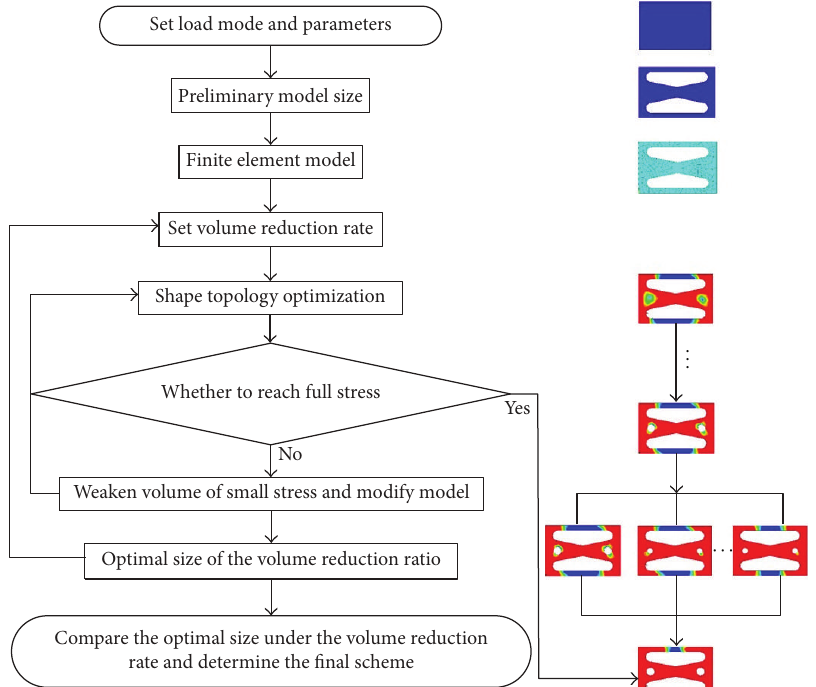
Figure 7: Optimization process.